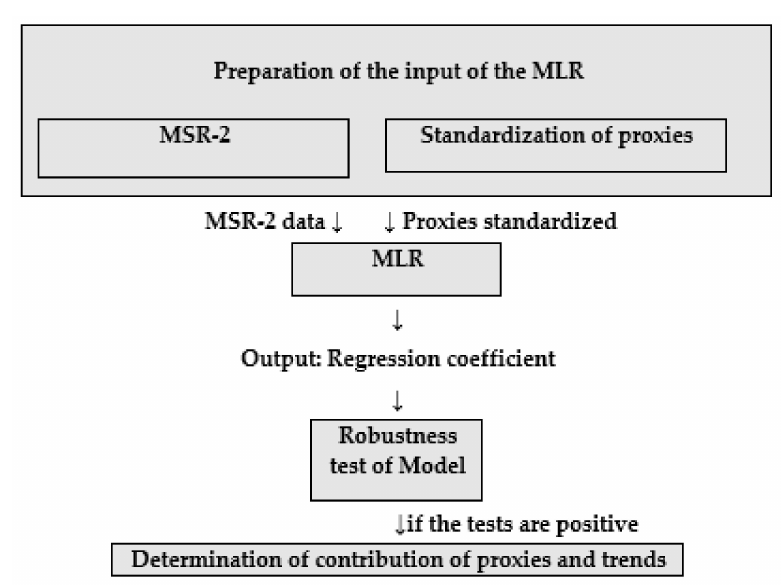
Figure A1. Flow chart of the methodology